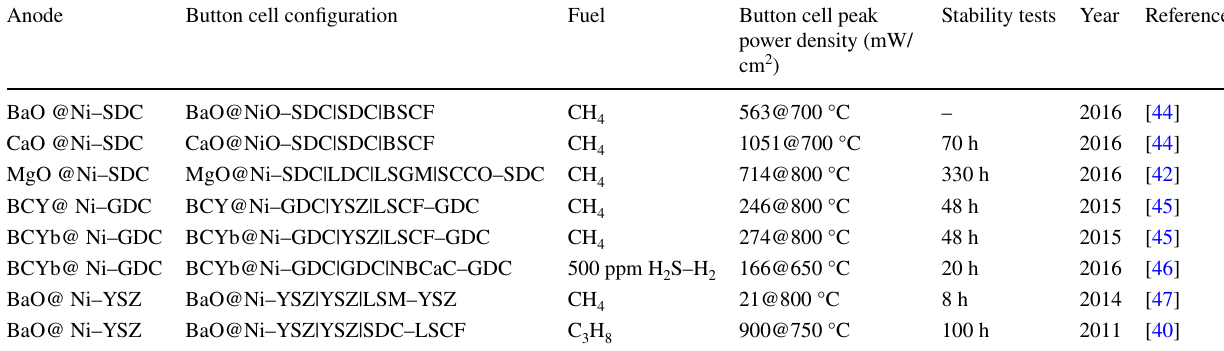
Table 4 Comparison of electrochemical performance of button cells decorated with alkaline